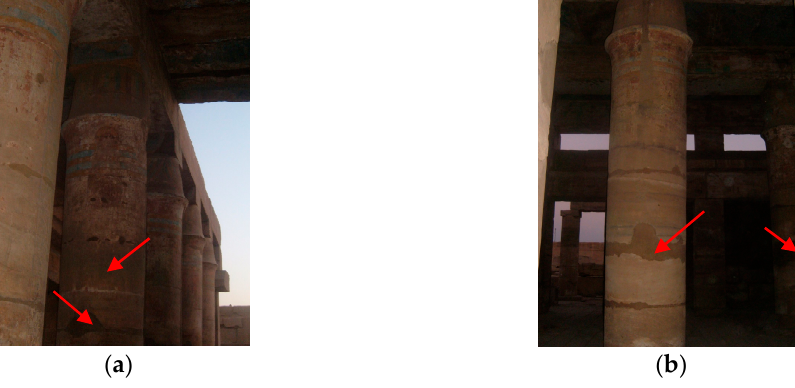
Figure 6. Hill shade ( a ) and two-dimensional (2D) ( b ) showing the topographic and elevation properties around the study area.